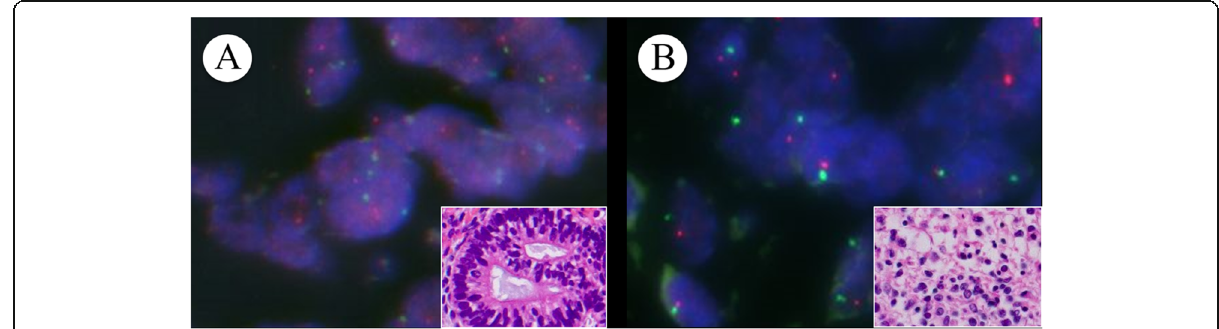
Fig. 4 Chromosome 12p to centromere ratio is not increased by FISH (green signals-12p telomere; red signals-12 centromere): ( a ) in immature / atypical glands (inset, H&E stain), and ( b ) in neuroepithelium (inset, H&E stain)